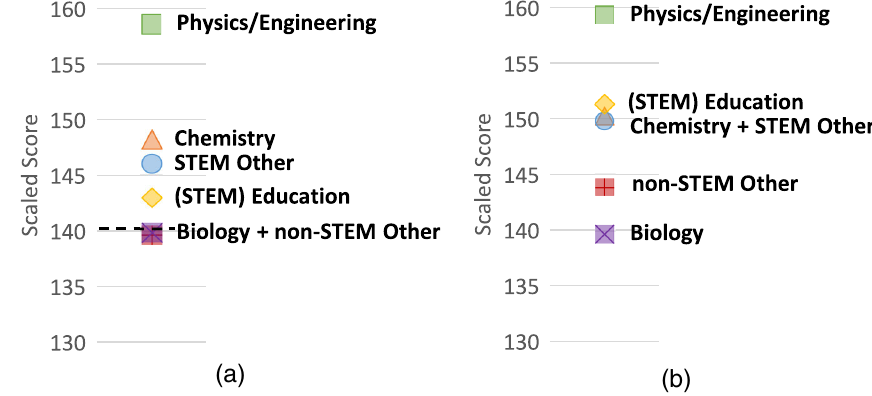
FIG. 2. Praxis physics subject assessment performance by examinees ’ reported (a) undergraduate major and (b) graduate major. Scaled score is plotted on the y axis. Dashed line represents the median passing score of 140 across states. Source: Derived from data provided by the Educational Testing